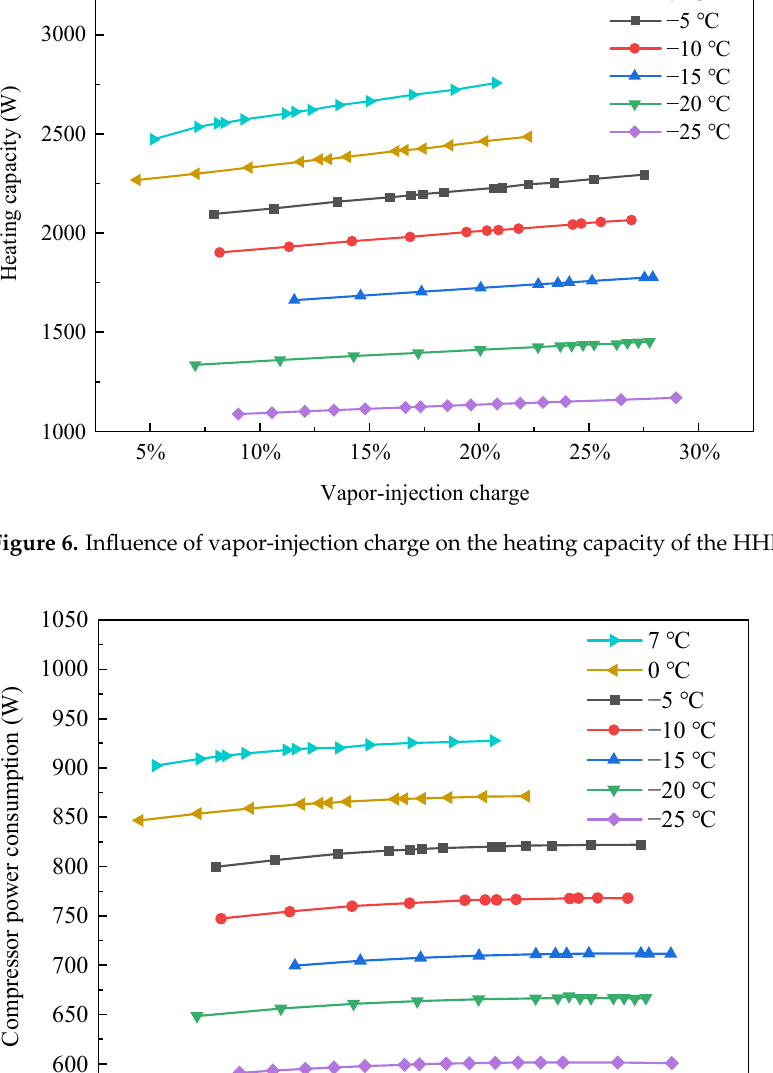
−15 ℃ −20 ℃ −25 ℃ Figure 8. The effect of vapor-injection charge on the COP of the HHE–ASHPD system. The enhanced vapor injection is used to increase system efficiency and lower com- pressor exhaust temperature since the conventional heat-pump system has a problem with high compressor exhaust temperature and low efficiency while operating at low evaporation temperature. The compressor exhaust temperature with the vapor-injection charge is shown in Figure 9. The compressor exhaust temperature decreases obviously as the vapor-injection charge increases. This is because the refrigerant’s entropy will de- crease during mixing as a result of the increased vapor-injection charge. The drop in en- tropy will result in a decrease in the compressor exhaust temperature when the isentropic efficiency of the compressor and condensation pressure is fixed. The compressor exhaust